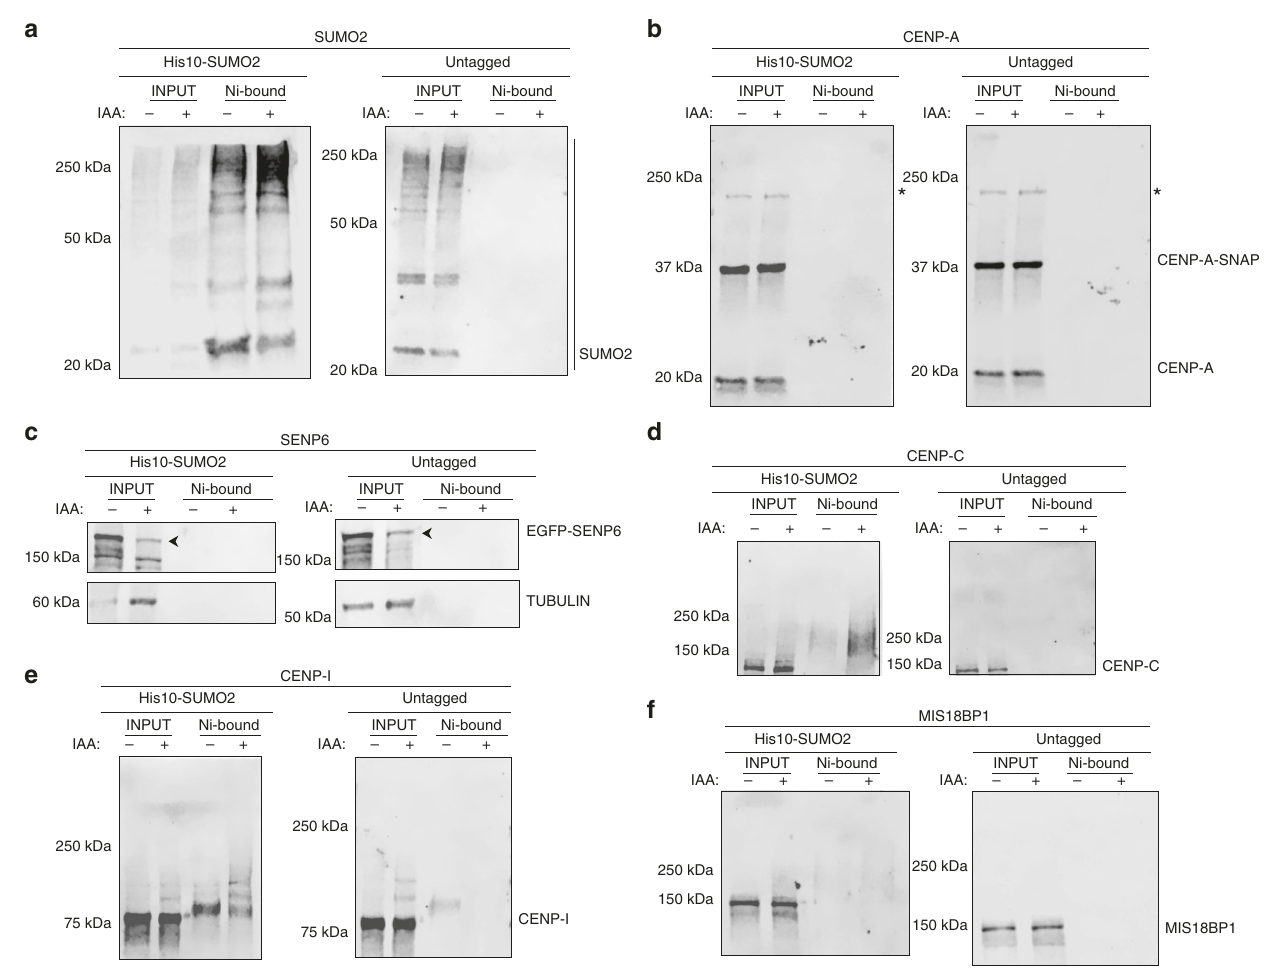
Fig. 6 CCAN subunits are polySUMOylated in absence of endogenous SENP6. SUMOylation targets of SENP6 in the inner kinetochore revealed by Immuno blotting of SDS-PAGE-separated His10-SUMO2 pull-downs from extracts of cells that were subjected to either control or auxin-mediated depletion of SENP6. a Blot probed for SUMO2 in control ‘ − ‘ vs. auxin treated ‘ + ' condition in His10-SUMO2 overexpressing cells and the parental untagged cells. b Blot as in a probed for CENP-A. Asterisk (*) indicates non-speci fi c band. c Blot as in a probed for SENP6. Arrowhead indicates the EGFP-SENP6 position. d Blot as in a probed for CENP-C. Note the His10-SUMO2 and SENP6 depletion-dependent accumulation of CENP-C-positive high molecular weight species. e Blot as in a probed for CENP-I. Note the His10-SUMO2 and SENP6 depletion-dependent accumulation of CENP-I-positive high molecular weight species. f Blot as in a probed for MIS18BP1. Source data are provided as a Source Data fi